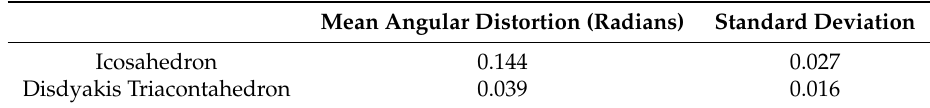
Figure 15. Circles on the spherical face of a DT shown in blue are projected to ellipses on the planar face of a DT shown in green. We can see that the angular distortion is minor because the major and minor axis of the ellipses are close to the same. Table 1. Mean and standard deviation of angular distortion (in radians) of the projection to the icosahedron and the DT. The mean for the DT is approximately four times less and the standard deviation is lower showing that projection to the DT has significantly reduced angular distortion.